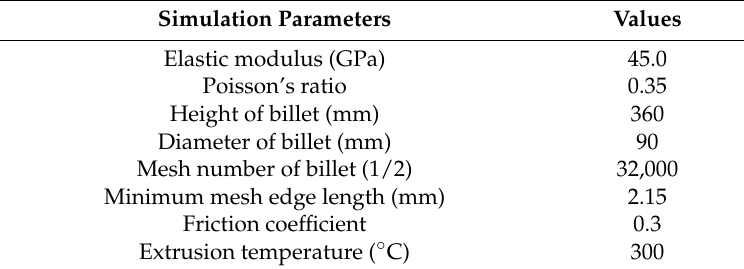
Table 1. The parameters of the simulation.